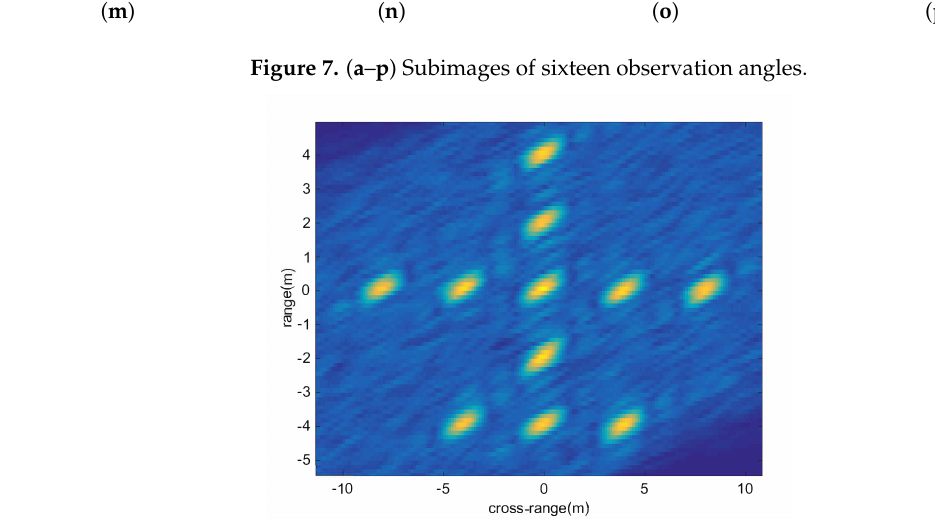
Figure 8. The fusion